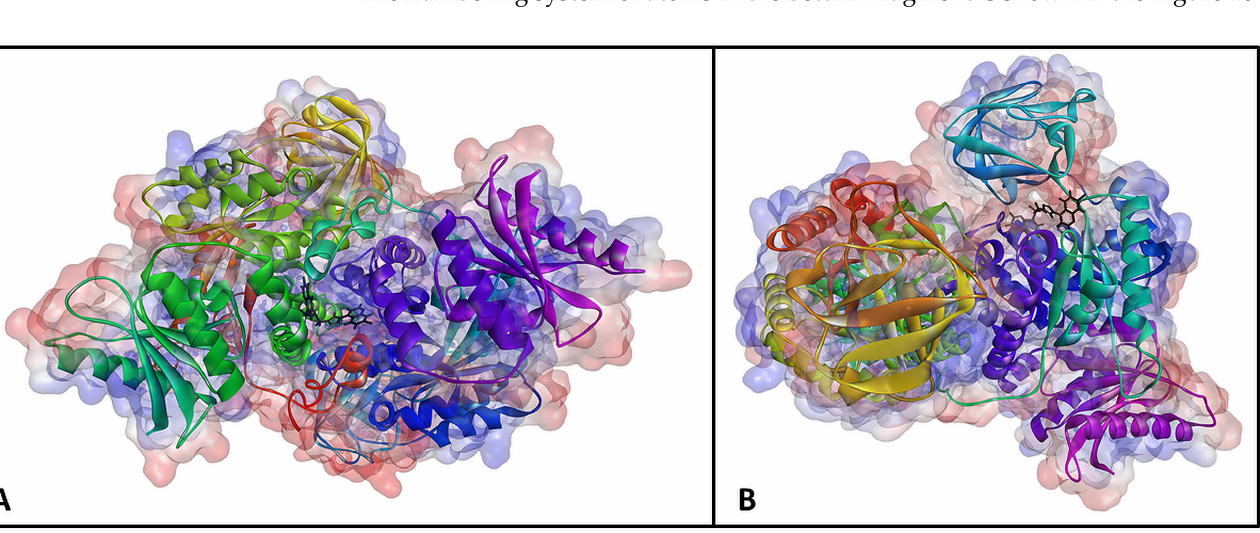
Figure 3 . Predicted binding models of 9a with dimeric form of PKM2 ( A : PDB ID 4G1N, B : PDB ID 4FXF ), where black spheres represent the ligand.